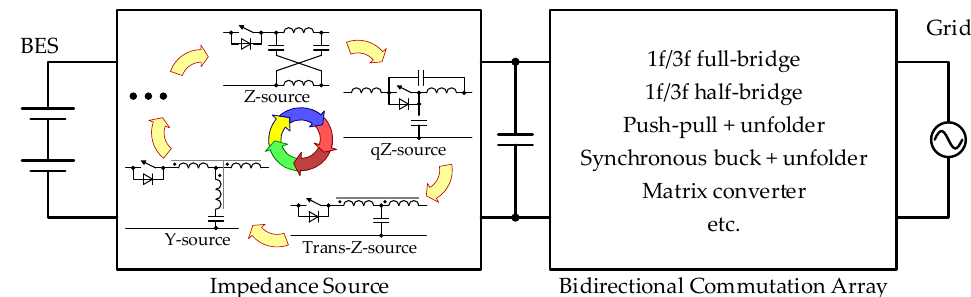
Figure 16. Generalized configuration of the BES interface converter with an impedance source.